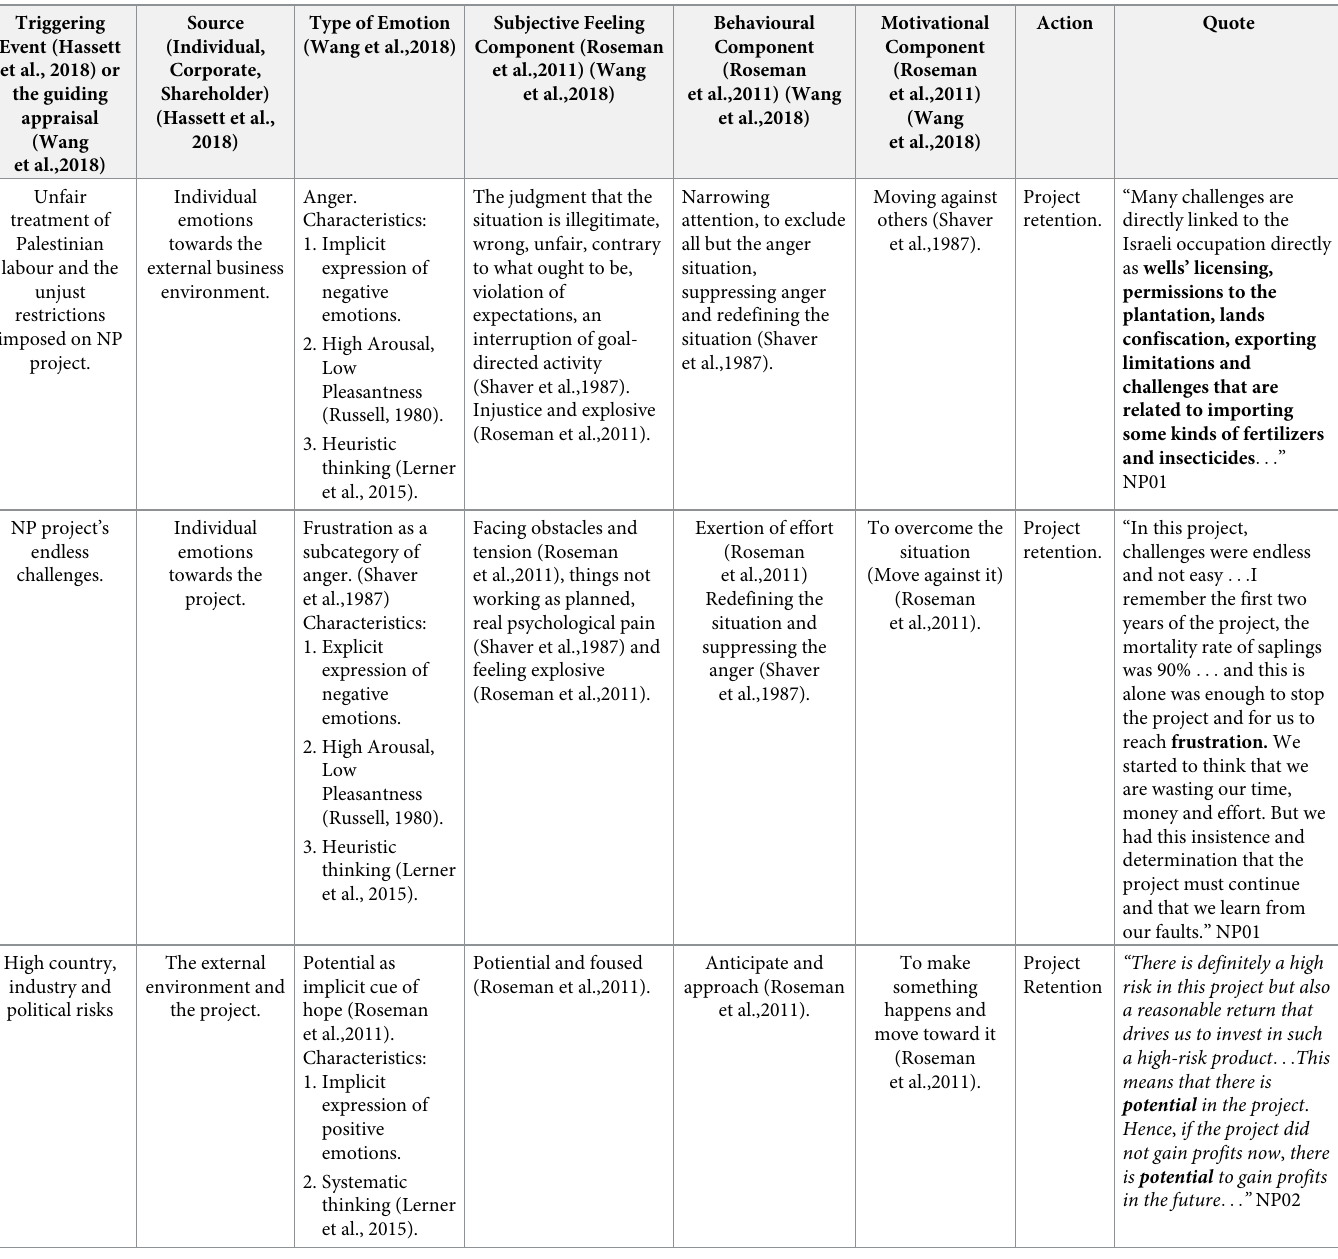
Table 2. The analysis of anger and